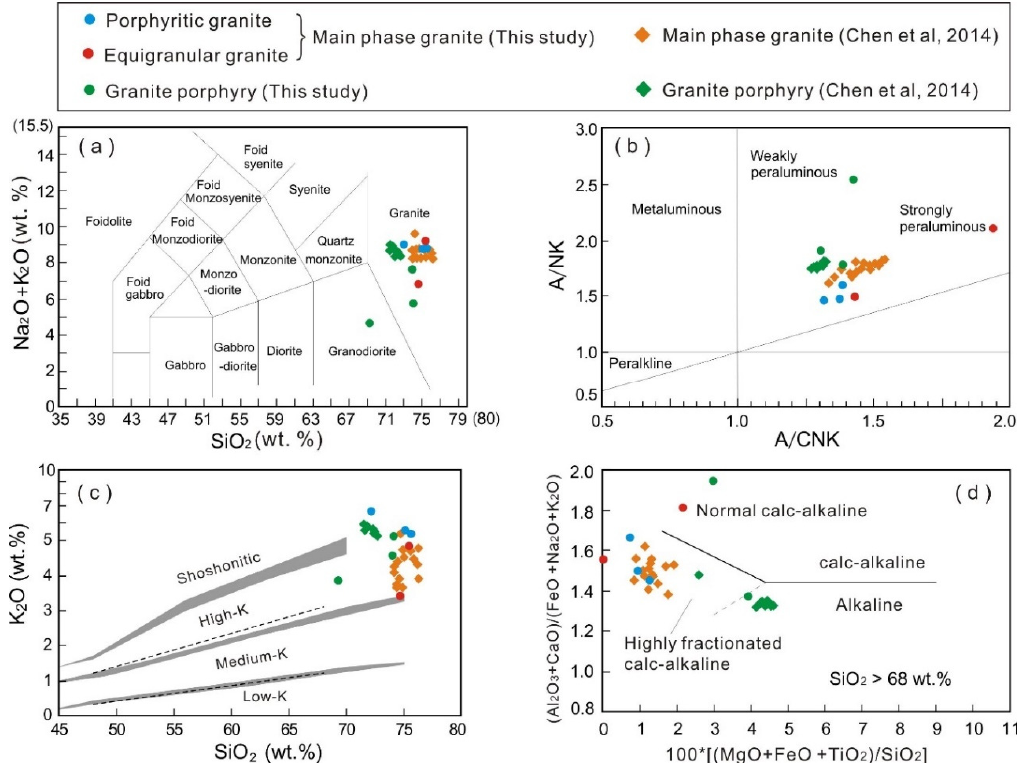
Figure 7. Geochemical classification of the Qianlishan granites: ( a ) total alkali vs. silica (TAS) diagram for classification [54]; ( b ) diagram of A/NK vs. A/CNK [55], A/NK = molar ratio of [Al 2 O 3 /(Na 2 O + K 2 O)], A/CNK = molar ratio of [Al 2 O 3 /(CaO + Na 2 O + K 2 O)]; ( c ) K 2 O vs. SiO 2 diagram [56]; and ( d ) (Al 2 O 3 + CaO)/(FeO + Na 2 O + K 2 O) vs. 100 * [(MgO + FeO + TiO 2 )/SiO 2 ] classification diagram [57]. Data cited from Chen et al. [20].